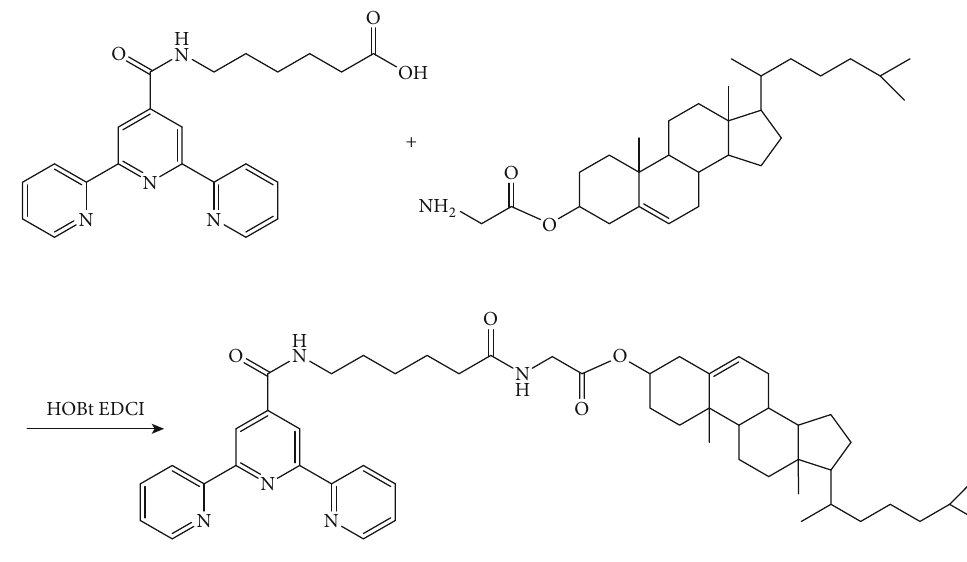
Figure 3: Synthesis route of DMTCP. Table 8: Elemental composition of